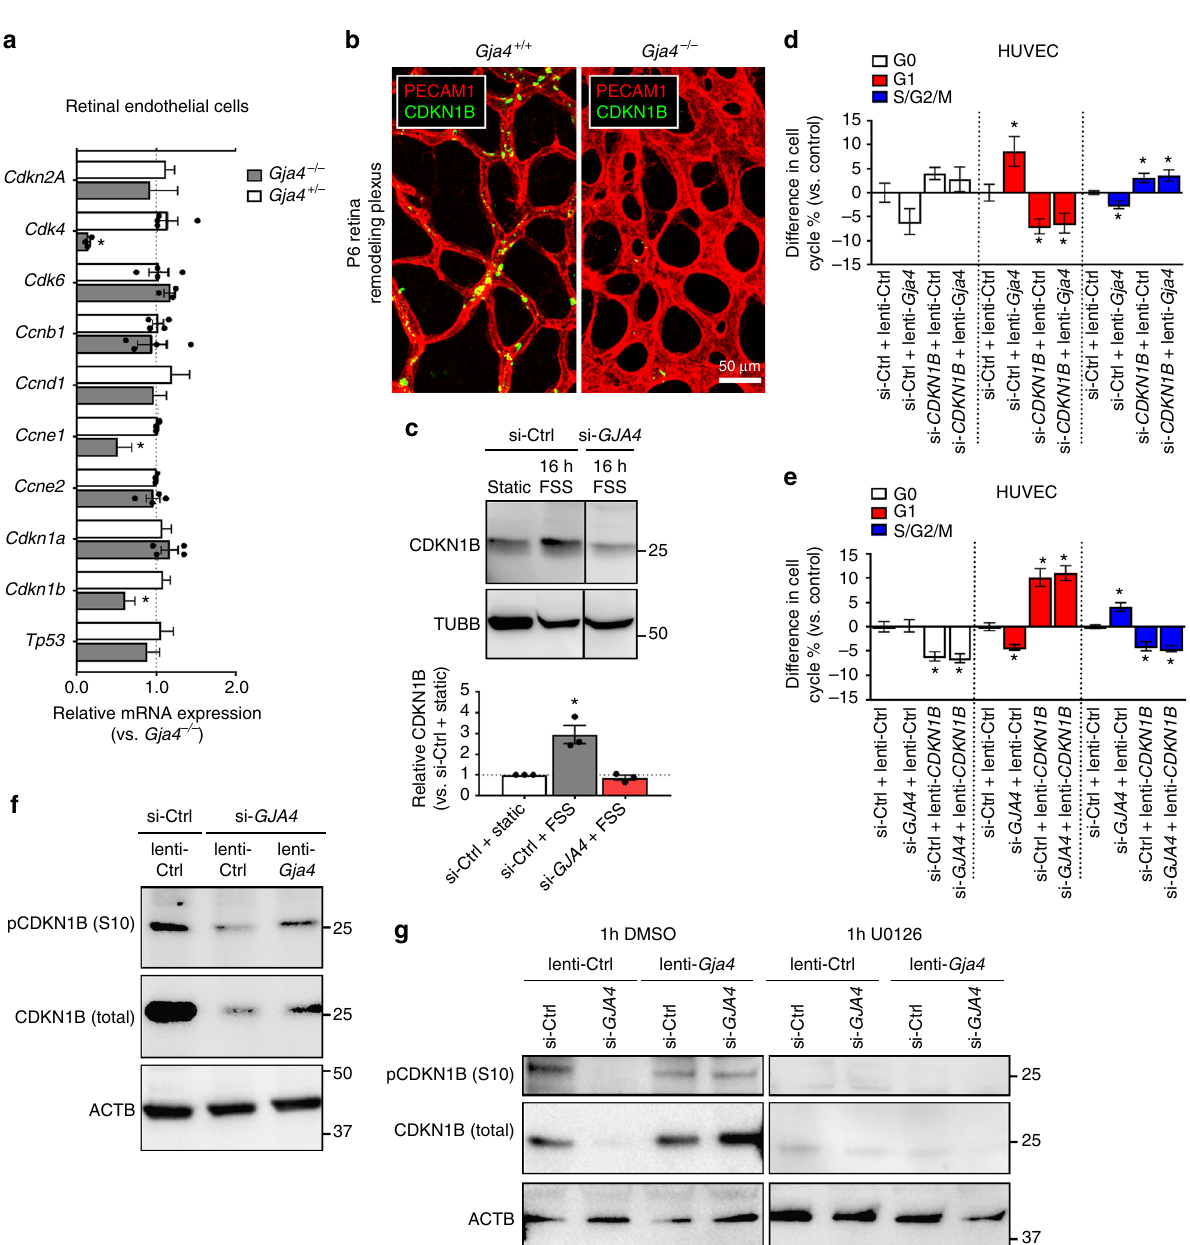
Fig. 5 GJA4 regulates endothelial cell cycle arrest via CDKN1B. a CDKN1B mRNA expression was signi fi cantly reduced in Gja4 − / − P6 retinal endothelial cells (CD31+/CD45 − ) (mean relative mRNA expression ± SEM vs. Gja4 +/ − littermate controls; n = 3 ( Cdk4 , Gja4 − / − ; Cdk6 , Gja4 − / − Ccne1 , Gja4 +/ − ; Ccne2 , Gja4 +/ − ), n = 4 ( Cdk4 , Gja4 +/ − ; Cdk6 , Gja4 +/ − ; Ccnb1 ; Cdkn1a , Gja4 − / − ), n = 5 ( Ccne1 , Gja4 − / − ), n = 6 ( Ccne2 , Gja4 − / − ; Cdkn1a , Gja4 +/ − ; Ccnd1 , Gja4 − / − ), n = 8 ( Cdk2 ; Tp53 , Gja4 − / − ), n = 9 ( Ccnd1 , Gja4 +/ − ; Cdkn1b ; Tp53 , Gja4 − / − ); individual values plotted where n < 5). b CDKN1B expression was detected in Gja4 +/+ , but not Gja4 − / − , endothelial cells of remodeling retinal vessels. (Colors: PECAM1 (red), CDKN1B (green); scale bar: 50 µ m). c CDKN1B protein was elevated in HUVEC by 16 h FSS, and this effect was abolished by si- GJA4 (mean densitometry ± SEM vs. Static; n = 3 for all groups; one-way ANOVA: p = 0.002, asterisks indicate p < 0.05 in post hoc t -test). Uncropped western blots presented in Supplementary Fig. 14A. d Constitutive GJA4 expression (lenti- Gja4 ) arrested endothelial cells in G1 and reduced actively cycling cells in S/G2/M, while si- CDKN1B had the opposite effect, regardless of GJA4 expression (mean difference in cell cycle % ± SEM vs. Control; n = 6; one-way ANOVA: p = 0.0002 (G1), p = 0.0003 (S/G2/M), asterisks indicate p < 0.05 in post hoc t -test vs. si-Ctrl + lenti-Ctrl). e GJA4 knockdown (si- GJA4 ) reduced the proportion of endothelial cells in G1 and increased the proportion in S/G2/M, and constitutive expression of CDKN1B (lenti- CDKN1B ) had the opposite effect, regardless of GJA4 expression (mean difference in cell cycle % ± SEM vs. Control; n = 3 for all groups; one-way ANOVA: p = 0.002 (G0), p < 0.0001 (G1), p < 0.0001 (S/G2/M), asterisks indicate p < 0.05 in post hoc t -tests vs. si-Ctrl+ lenti-Ctrl). f CDKN1B phosphorylation at serine 10 (pCDKN1B (S10)) and total protein levels were reduced by si- GJA4 and rescued with lenti- Gja4 . Uncropped blots presented in Supplementary Fig. 14B. g MAPK/ERK signaling inhibition by 1 h treatment with 20 µ M U0126,